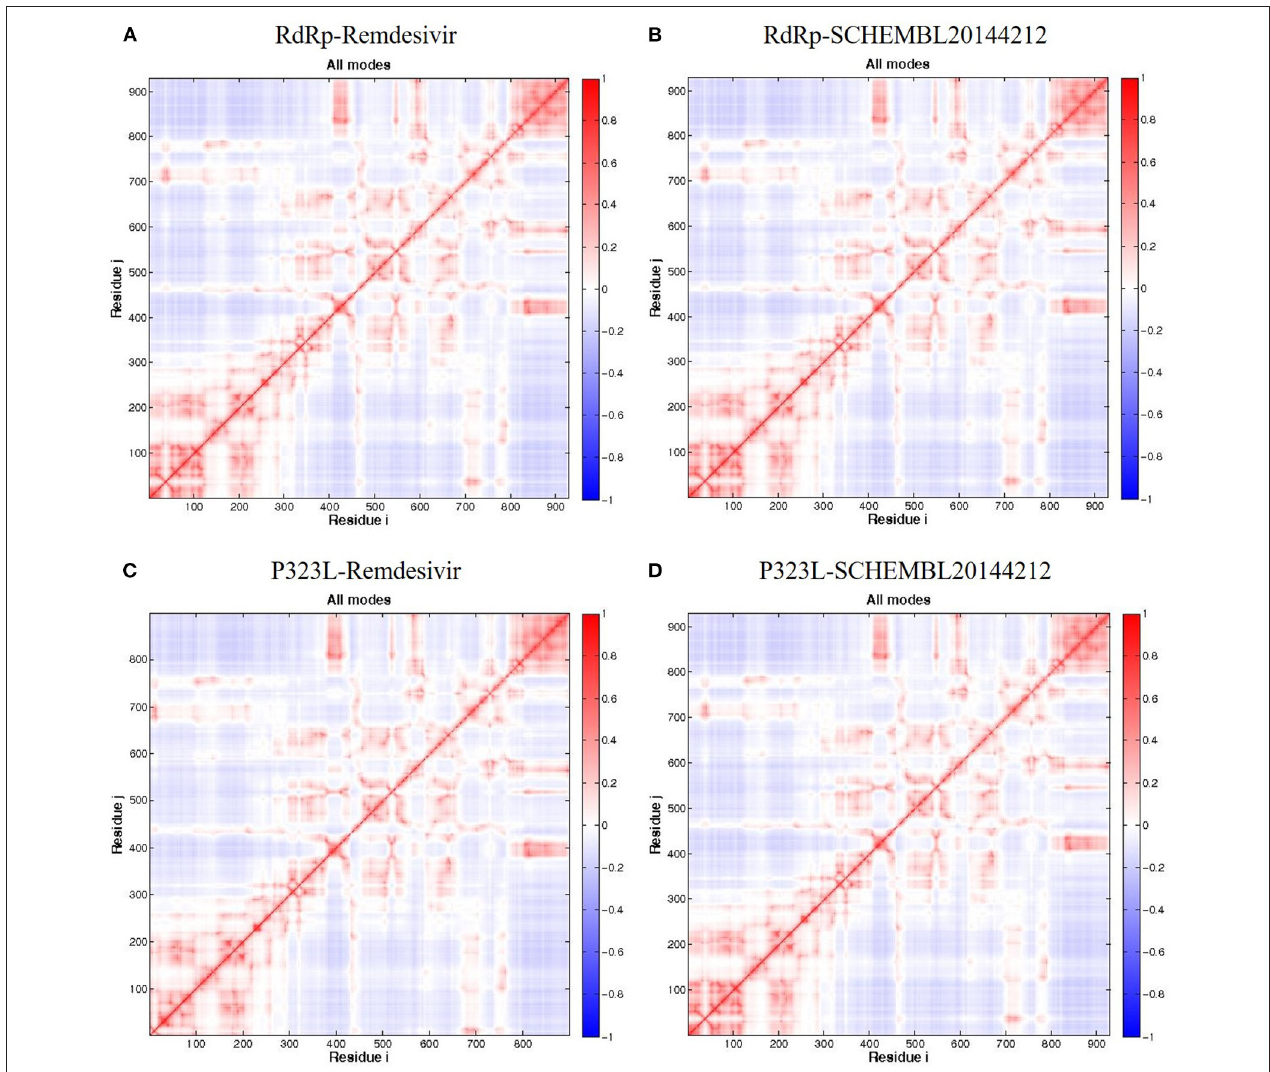
FIGURE 4 | DCCM of the residues around their mean position for all docked RdRp complexes. (A) RdRp-Remdesivir; (B) RdRp-SCHEMBL20144212; (C) P323L-Remdesivir; (D) P323L-SCHEMBL20144212. Map size = 100, min i = 5, and min j = 5. The color ranges from − 1 (blue) to + 1 (red), whereas 0 remains in white